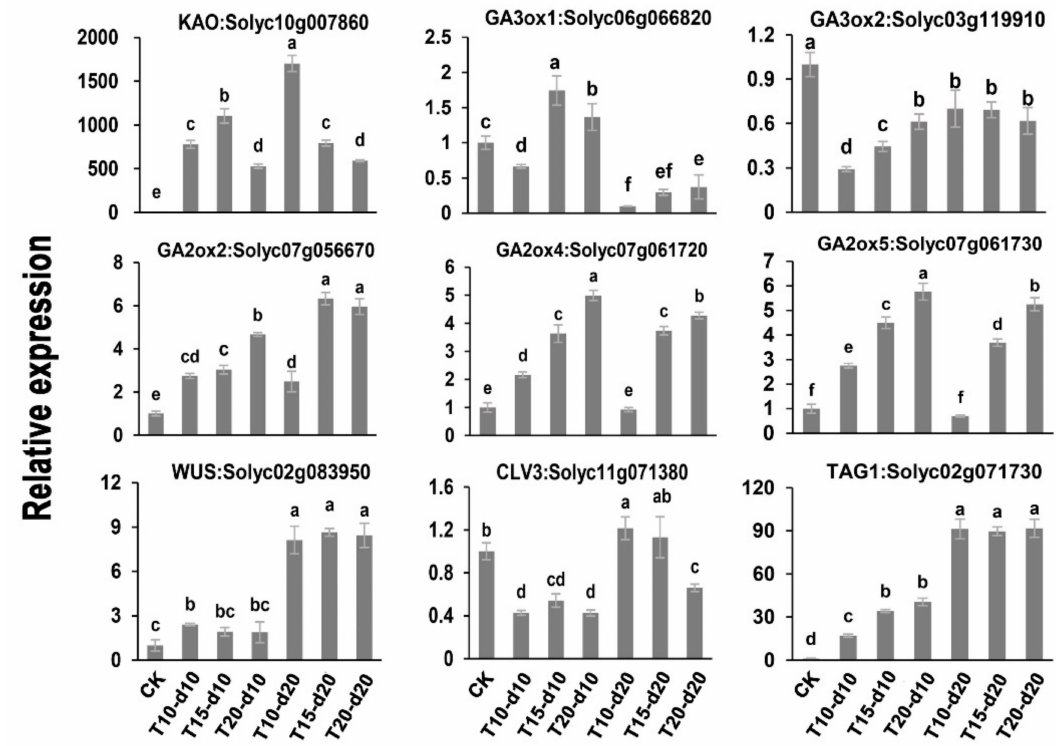
Figure 5. qRT-PCR analysis of KAO , GA3ox1 , GA3ox2 , GA2ox2 , GA2ox4 , GA2ox5 , WUS , CLV3 , and TAG1 in the shoot apex at CK (as control), T10-d10, T15-d10, T20-d10, T10-d20, T15-d20, and T20-d20 to confirm RNA sequencing (RNA-seq) data. The data are the mean values corresponding to three independent experiments. The error bars represent the standard errors. Di ff erent lowercase letters represent significant di ff erences ( p < 0.05, Duncan’s multiple range